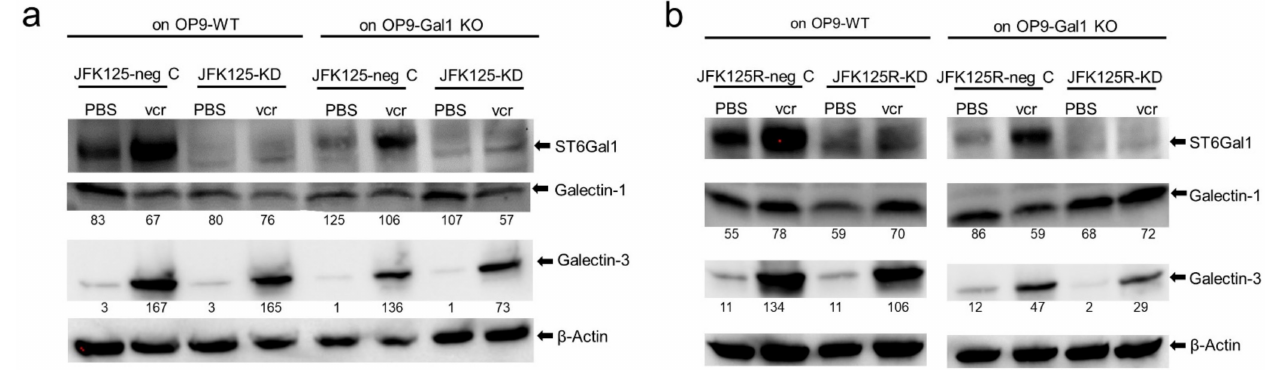
Figure 8. Drug-resistant JFK125 and JFK125R cells contain constant Galectin-1 with increased Galectin- 3. JFK125 ( a ) or JFK125R ( b ) cells were harvested from co-cultures with OP9 wild-type (WT) or Galectin-1 knockout (KO) cells as indicated after treatment for 14 days with 1.5 nM vincristine or PBS. Antibodies used for Western blotting are indicated to the right and include ST6Gal1 (1:500), Galectin-3 (1:1000), Galectin-1 (1:1000), and β -actin (1:500, Santa Cruz); 4–20% SDS-PAA gradient gel; 1.6 × 10 6 cell equivalents loaded per well. Numbers below the Galectin-1 and Galectin-3 panels indicate the percentage of β -actin loading control signal in each lane by ImageJ quantification of shorter chemiluminescent exposures of the same Western